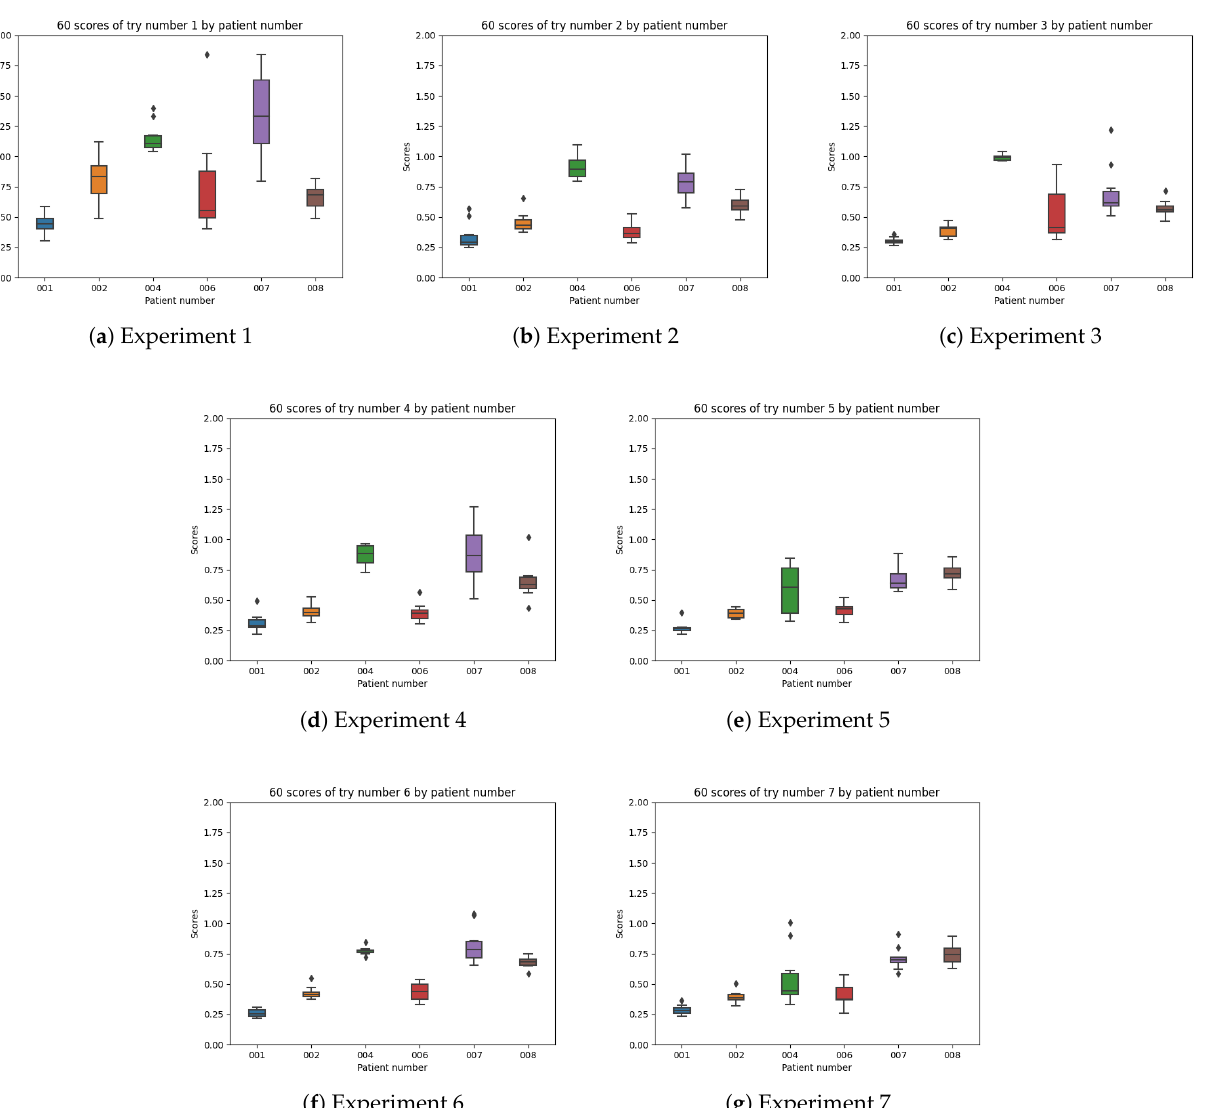
Figure 19. Experiments